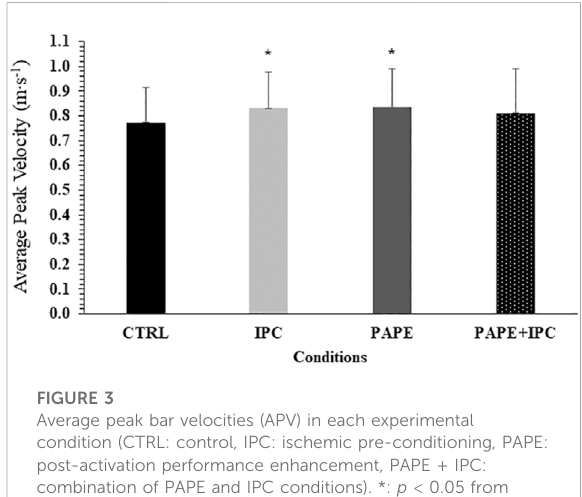
FIGURE 4 Total number of repetitions (all sets included) in each experimental condition (CTRL: control, IPC: ischemic pre- conditioning, PAPE: post-activation performance